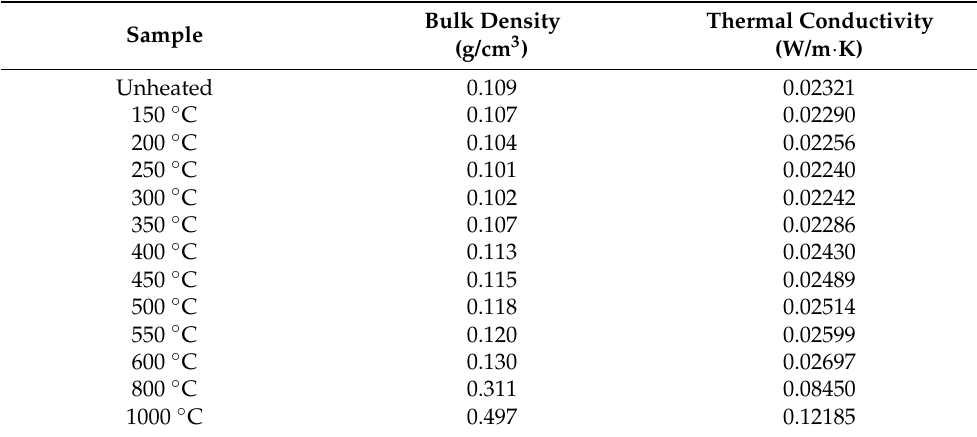
Figure 1. Preparation process and heat treatment optimization of hydrophobic silica aerogel. Table 1. Thermal properties of the silica aerogel